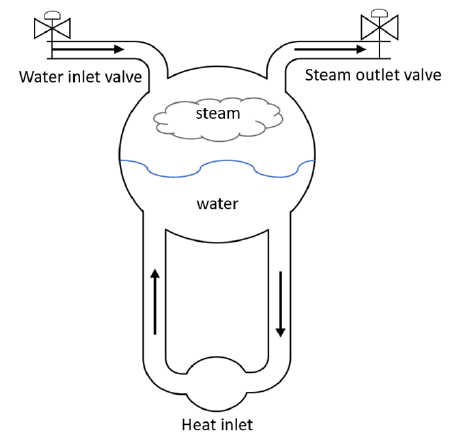
Figure 1. Schematic representation of the drum